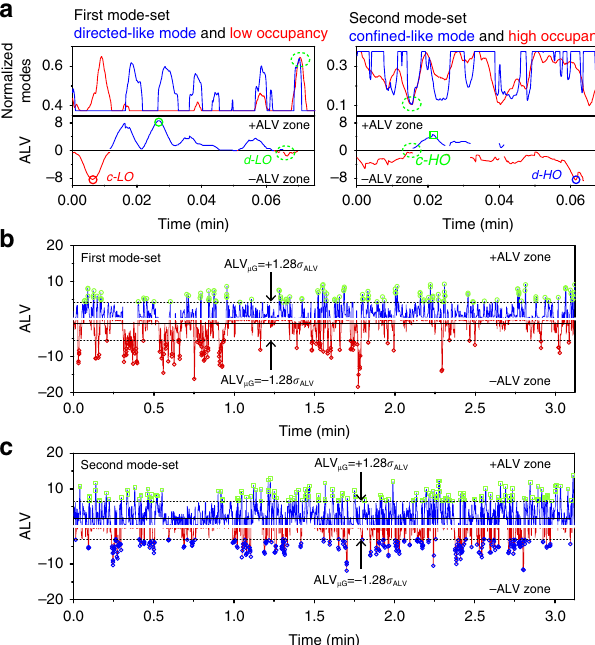
Figure 6 | Identification of the sub-modes by amplitudes of the local variations. ( a ) Temporal profiles of normalized P 25 (red) and MSD- D t (blue) (top) and the amplitudes of the local variations (ALV) (bottom) of the first (left) and second (right) mode-set obtained from an experimental replicate of ColE 1 DNA. ( b ) ALV- D t profile obtained from the first mode-set. The green circles indicate that the amplitudes of the directed-like mode are higher than those of the relative mode. The red circles indicate that the amplitudes of the low occupancy mode are higher than those of the absolute mode. ( c ) ALV- D t profile obtained from the second mode-set. The green squares indicate that the amplitudes of the confined-like mode are lower than those of the relative mode. The blue circles indicate that the amplitudes of the high occupancy mode are lower than those of the absolute